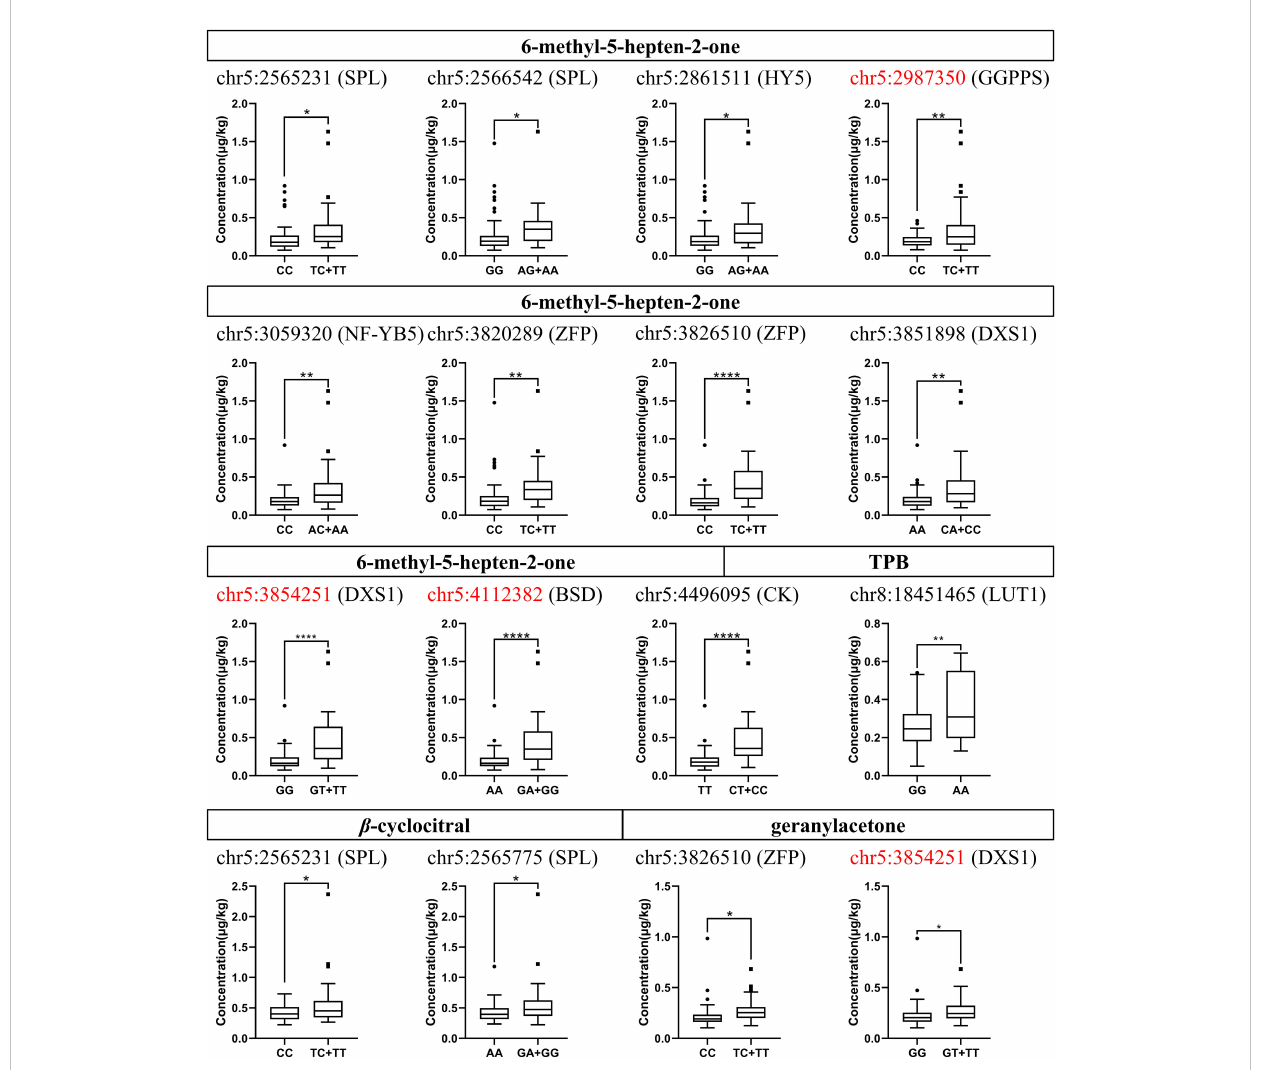
FIGURE 4 Concentration distribution box plots of different genotypes at candidate SNP loci in the grapevine germplasm population. The concentration ranges in the vertical coordinates are the compound concentration data obtained from 97 individuals. The capital letters to the right of the SNP loci are the symbols of the genes which these loci are located in. The SNP loci highlighted in red represent non-synonymous mutations. SPL, squamosa promoter-binding like protein 1; HY5, bZIP protein HY5; GGPPS, geranyl-geranyl diphosphate synthase; NF-YB5, Nuclear transcription factor Y subunit B-5; ZFP, zinc fi nger proteins; DXS1, 1-deoxy-D-xylulose-5-phosphate synthase; BSD, BSD domain-containing protein; CK, carbohydrate kinase; LUT1, carotene ϵ -monooxygenase. The asterisks *, **, and ****, indicate signi fi cant levels at p <0.05, p <0.01 and p <0.0001,